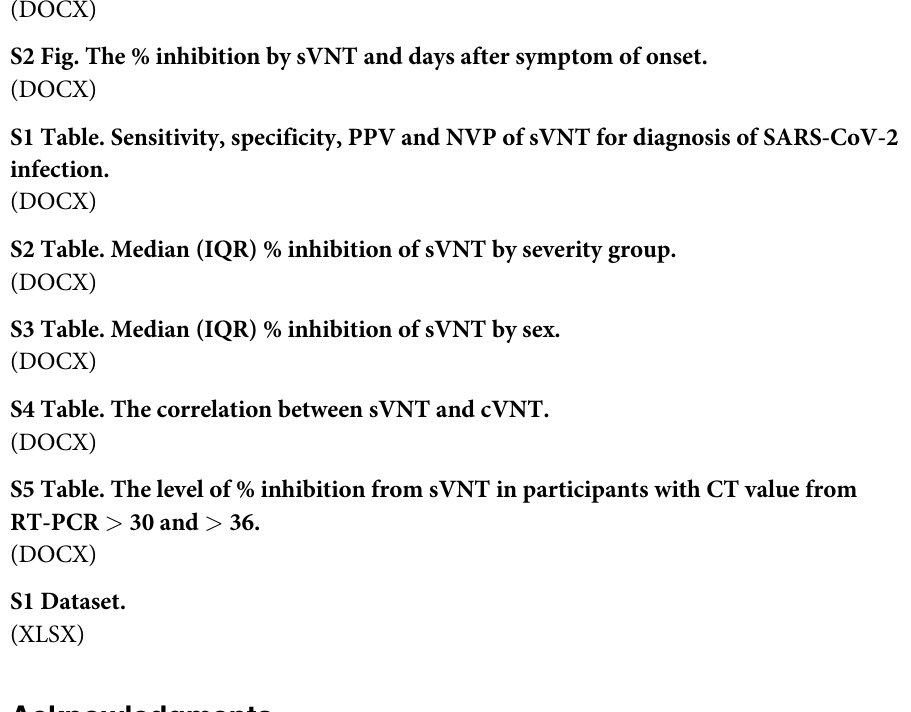
S1 Table. Sensitivity, specificity, PPV and NVP of sVNT for diagnosis of SARS-CoV-2 infection. S2 Table. Median (IQR) % inhibition of sVNT by severity group. S3 Table. Median (IQR) % inhibition of sVNT by sex. S4 Table. The correlation between sVNT and cVNT. S5 Table. The level of % inhibition from sVNT in participants with CT value from RT-PCR > 30 and >